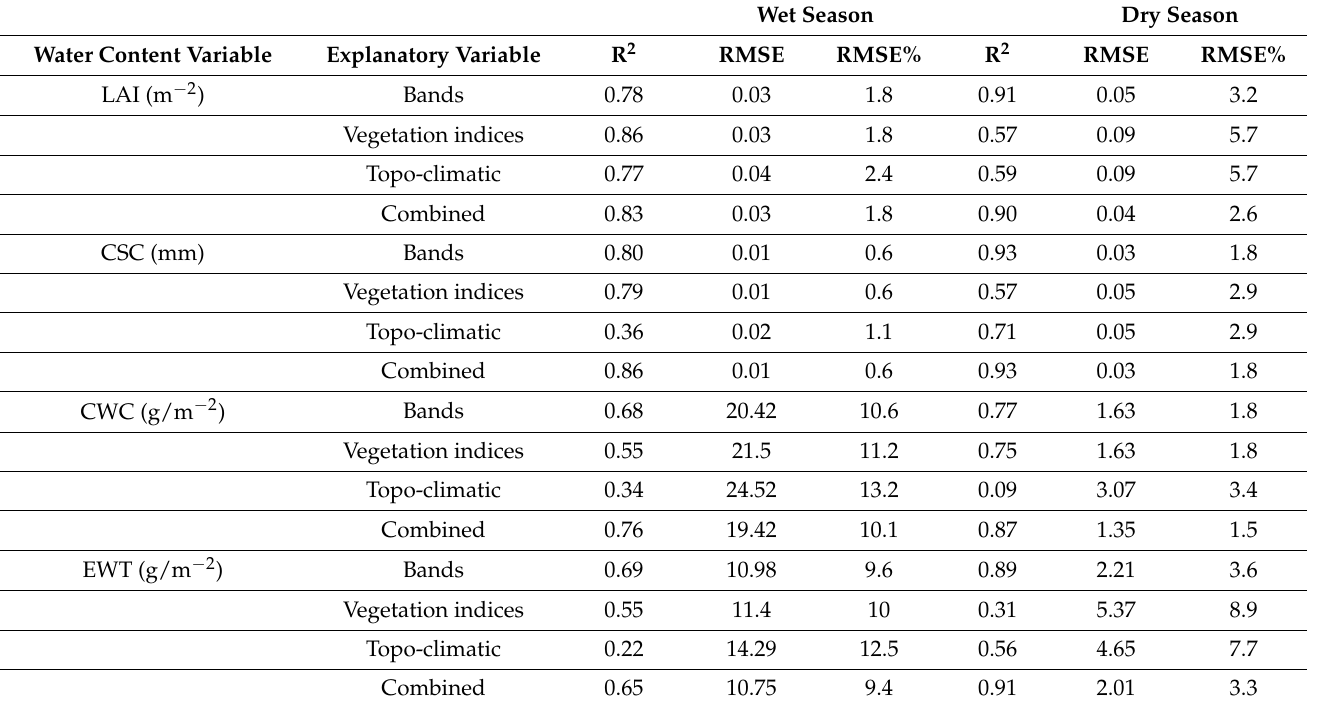
Table 3. Estimation accuracies of LAI, CSC, CWC, and EWT derived using spectral data and topo- climatic